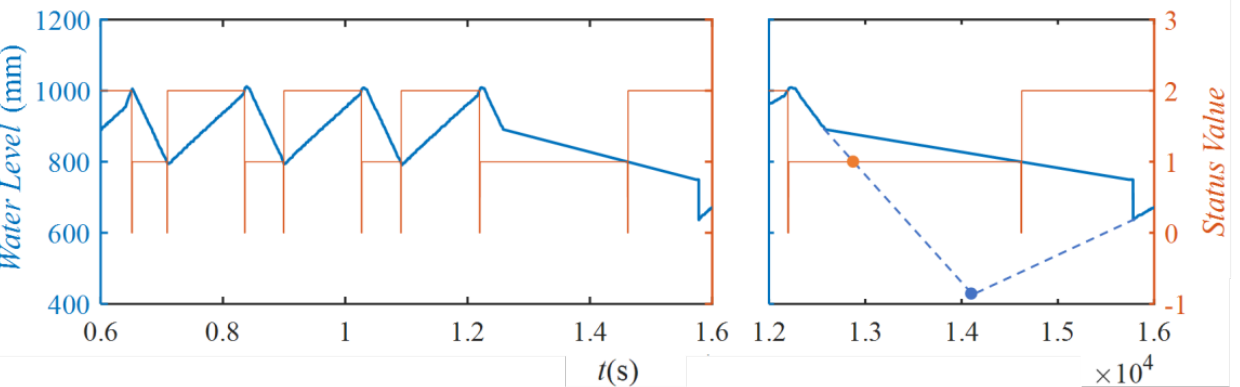
Figure 7. Sophisticated attack in dataset 5. Blue line = value of LIT301 and orange line = status value of MV201.